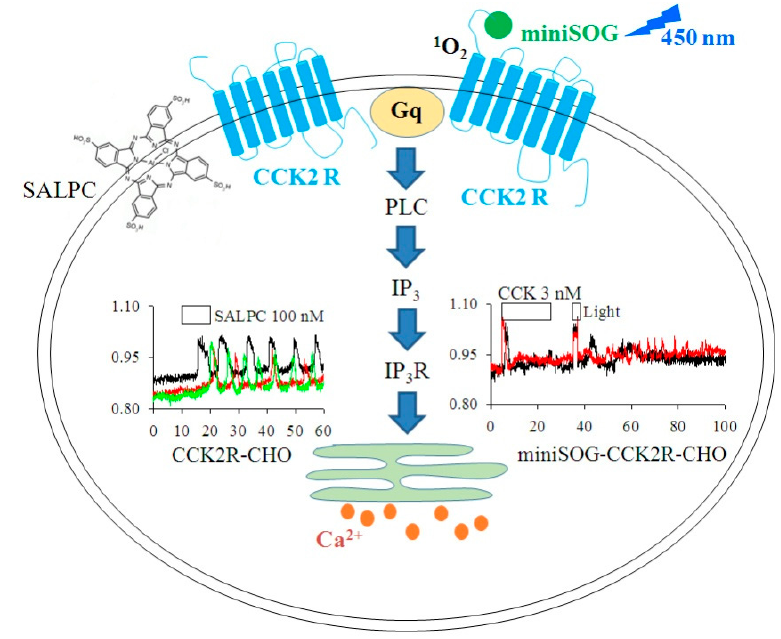
Figure 6. SALPC in the dark and miniSOG photodynamic action permanently activated CCK2R. (1) SALPC in the dark as an agonist for CCK2R to trigger persistent calcium oscillations in CCK2R-CHO-K1 cells. (2) The miniSOG photodynamic activation of CCK2R (miniSOG-CCK2R) elicited persistent calcium oscillations in miniSOG-CCK2R-CHO-K1 cells. Gq, G protein; PLC, phospholipase C; IP 3 R, IP 3 receptor / channel complex; ER, endoplasmic reticulum. SALPC irradiated with light > 580 nm and miniSOG at 450 nm. 1 O 2 was produced in photodynamic action with miniSOG.